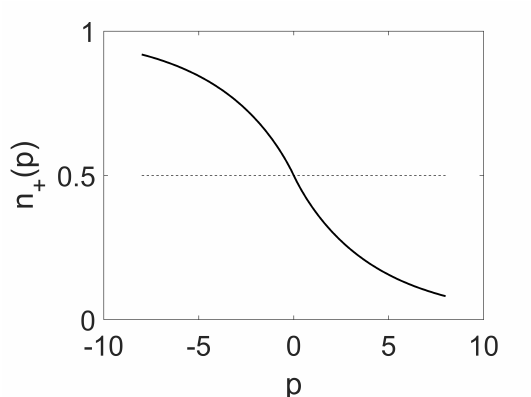
Figure 5: The plot of n + vs p . The parameters used to generate the plot are r = 0.2, = 1, and γ = ˜ v f